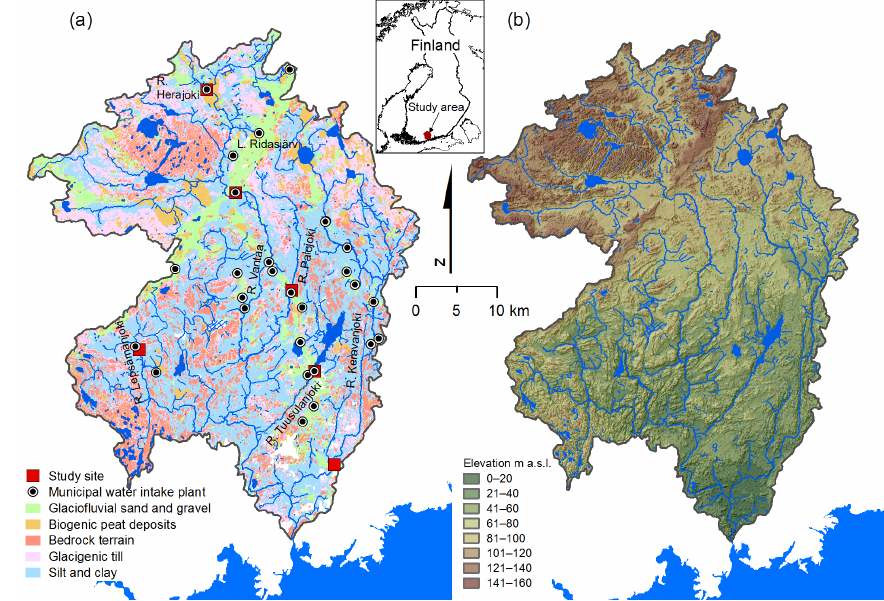
Figure 1. (a) Quaternary deposits and study sites in the River Vantaa catchment. End-moraine ridges are included into glaciofluvial sand and gravel, and cover-moraine sheets into glacigenic till, respectively. (b) Elevation model of the River Vantaa catchment. (Basemap Database © National Land Survey of Finland 2010; Quaternary Deposit Database © Geological Survey of Finland 2008; Watershed Database © SYKE 2010; Topographic Database © National Land Survey of Finland 2010.)